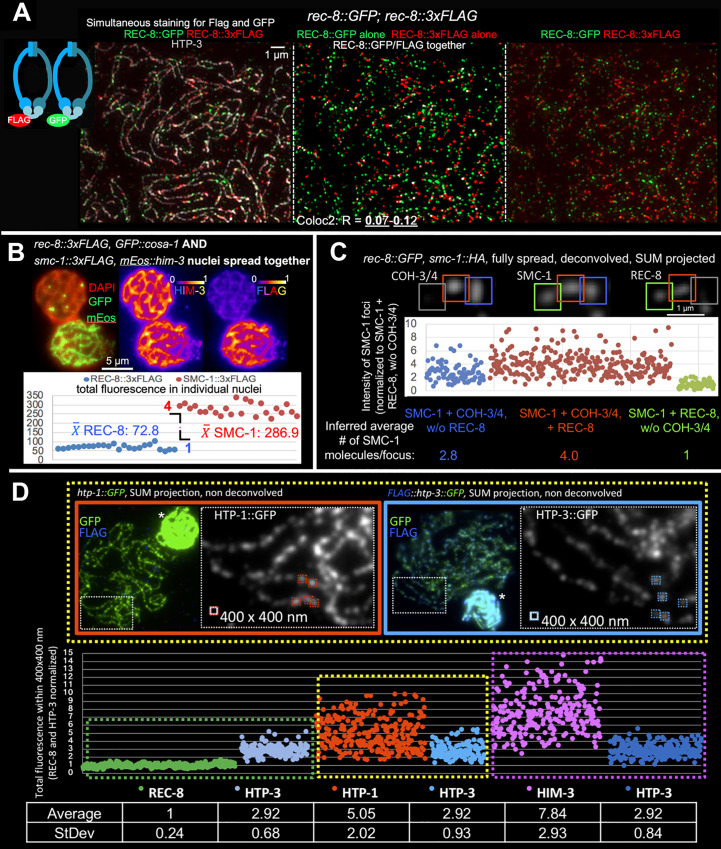
Quantitation of numbers of chromosome axis proteins present in individual axis foci.(A) Sample SIM images of fully spread nuclei from a worm expressing both REC-8::GFP and REC-8::3xFLAG, immunostained for HTP-3, FLAG, and GFP. All primary antibodies (anti-FLAG, ant-GFP, and anti-HTP-3) were applied at the same time. Middle panel was generated using ImageJ plugin “ColocThreshold,” with white indicating the infrequent pixels with significant FLAG and GFP colocalization (colocalizing pixels are in white; noncolocalizing pixels are in red and green); contrast and brightness were adjusted for display to improve visibility of the white pixels. Although GFP and FLAG signals both localize to chromosome axes (marked by HTP-3, left), they usually do not colocalize with each other. Coloc2 analysis using ImageJ confirmed the infrequent colocalization of FLAG and GFP by pixel intensity-based assessment (R(total) = 0.07–0.12; n = 28 nuclei). (B) Comparing the total amounts of chromatin-bound SMC-1 and REC-8. Gonads from worms expressing either SMC-1::3xFLAG and mEos::HIM-3 or REC-8::3xFLAG and GFP::COSA-1 were spread together on the same slides, immunostained for HIM-3 and FLAG, and imaged together using the same conditions. GFP::COSA-1 and mEos::HIM-3 served as internal markers to identify the genotypes of the nuclei being imaged; for the example nuclei depicted, similarities and difference in fluorescence intensities for HIM-3 and FLAG signals are illustrated using the indicated color scheme (generated using the Fire LUT from ImageJ). Graph indicates the total FLAG fluorescence measured in ROIs surrounding individual nuclei in SUM-intensity projections; each data point represents a single nucleus. For each genotype, 6 late pachytene nuclei each from 4 different gonads were assayed. All values obtained are displayed, with no normalization applied. The ratio of the average total fluorescence values is 1 REC-8::3xFLAG: 3.94 SMC-1::3xFLAG. (C) Inferred number of SMC-1 molecules in individual axis foci. The total fluorescence for SMC-1::HA, REC-8::GFP, and COH-3/4 was measured in individual 800 × 800 nm ROIs surrounding individual foci in SUM-intensity projections of fully spread nuclei; each data point represents the total fluorescence of SMC-1::HA in a single focus. As indicated in the cropped image on the top, SMC-1 foci were categorized as localizing with COH-3/4 but not REC-8 (blue, left in the graph); localizing with both COH-3/4 and REC-8 (red, middle in the graph); or localizing with REC-8 but not COH-3/4 (green, right). All values obtained are plotted in the graph on the bottom. The Y-axis (representing arbitrary fluorescence units) is normalized to the mean fluorescence of SMC-1 foci that only localize with a REC-8 focus but not with a COH-3/4 focus; this value is set to 1, because we consider REC-8 foci to represent single cohesin complexes. (D) Sample images (top) and quantitative data (graph and table) for experiments measuring fluorescence intensities of individual foci in parallel for pairwise combinations of axis proteins. Nuclei from worms expressing 3xFLAG::HTP-3::GFP and nuclei from worms expressing REC-8::GFP, HTP-1::GFP, or GFP::HIM-3 were spread together on the same slides, immunostained for GFP and FLAG, and imaged together using the same conditions. Presence or absence of FLAG staining (blue in the sample images) was used identify the genotype of the nuclei; asterisks indicate unspread nuclei of the same genotype that were present in the same field. Total fluorescence was measured in 400 × 400 nm ROIs surrounding well-separated individual foci in SUM-intensity projections; each data point represents a single focus. Different pairwise data sets were normalized to each other using the mean fluorescence of HTP-3::GFP foci as a normalization standard. The Y-axis (representing arbitrary fluorescence units) is normalized to mean REC-8::GFP = 1, because we consider REC-8 foci to represent single molecules. Plotted values for panels B, C, and D are available in S1 Data. ROI, region of interest; SIM, structured illumination microscopy.